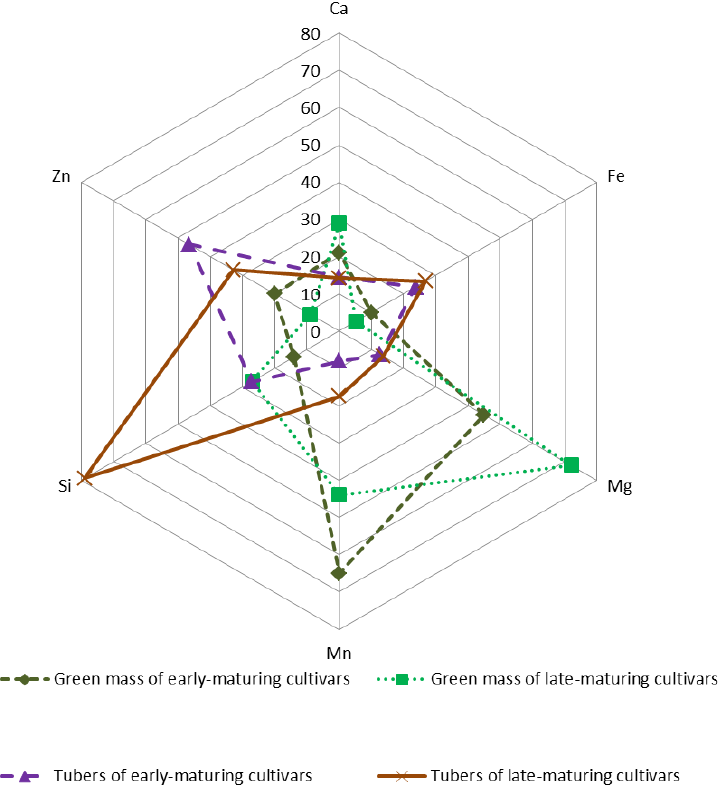
Figure 10. The content of trace elements in JA green mass and tubers, depending on the period of herbage wilting, mg/100 g.